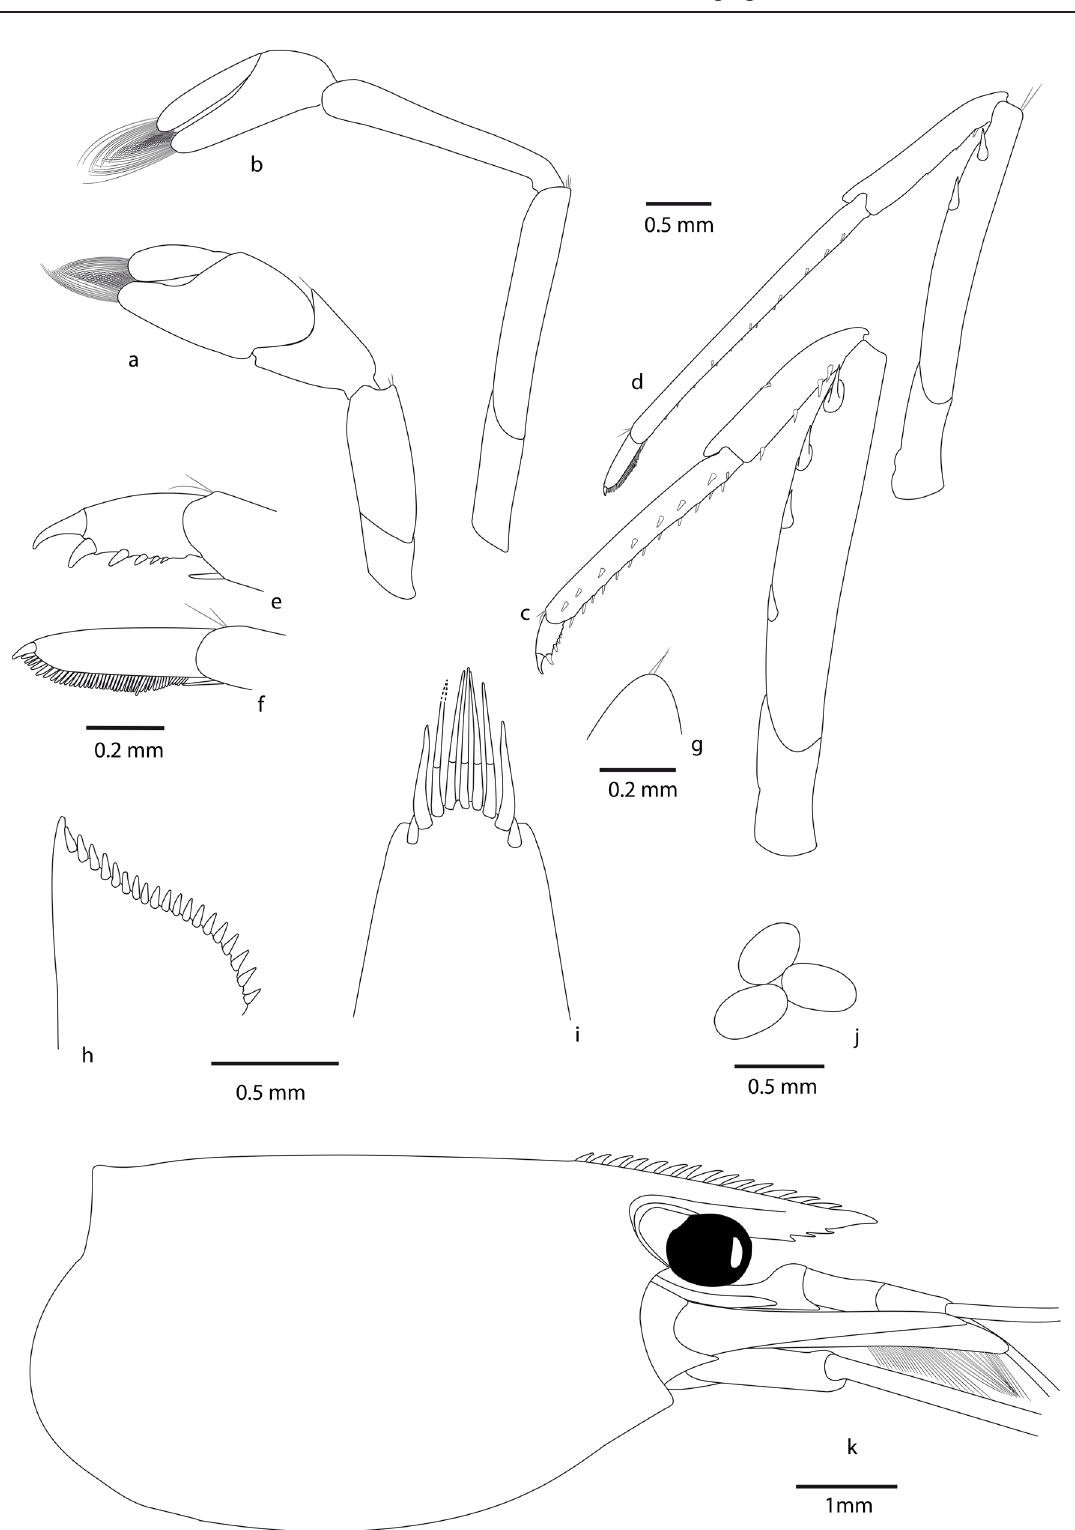
Fig. 11. Caridina turipi sp. nov. a . First pereiopod. b . Second pereiopod. c . Third pereiopod. d . Fifth pereiopod. e . Dactylus of third pereiopod. f . Dactylus of fifth pereiopod. g . Pre-anal carina. h . Uropodal diaeresis. i . Telson. j . Eggs. k . Cephalothorax. MNHN-IU-2014-20883 (a–f, h, j–k), MNHN- IU-2014-20882 (g) and MNHN-IU-2014-20878